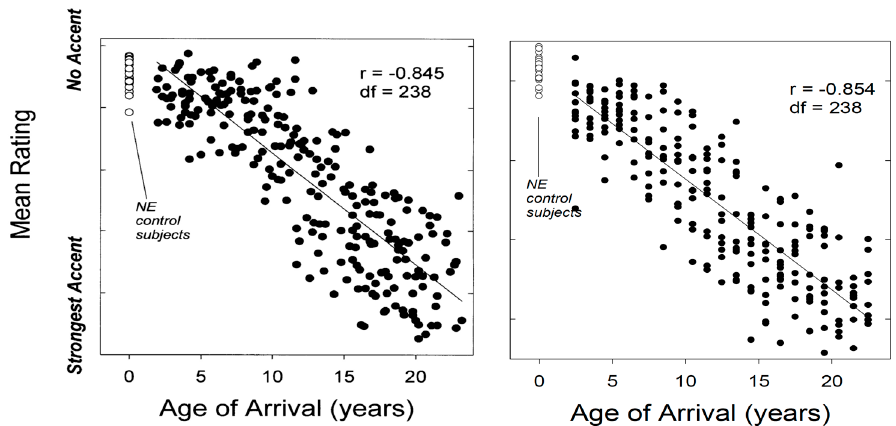
Figure 3. The relationship between AoA and L2 accentedness. Left image: L2 English accent ratings for 240 Italian native speakers (dark circles), and ratings for 24 native English controls (open circles); all participants were residents of Ottawa (adapted by Jim Flege from Flege 1999, fig. 5.1; data originally from Flege et al. 1995, republished with permission from Taylor & Francis Group). Right image: L2 English accent ratings for 240 Korean native speakers (dark circles), and accent ratings for 24 native English-speaking controls (open circles); Korean participants resided in the Washington, DC, area and English natives were born in the US and lived in Mid-Atlantic states (adapted by Jim Flege from Yeni-Komshian et al. 2000, fig. 1, republished with permission from Cambridge University Press). In both instances, AoA > ~6–10 y is associated with a stronger (less English-like) accent and with greater dispersion of accent ratings.